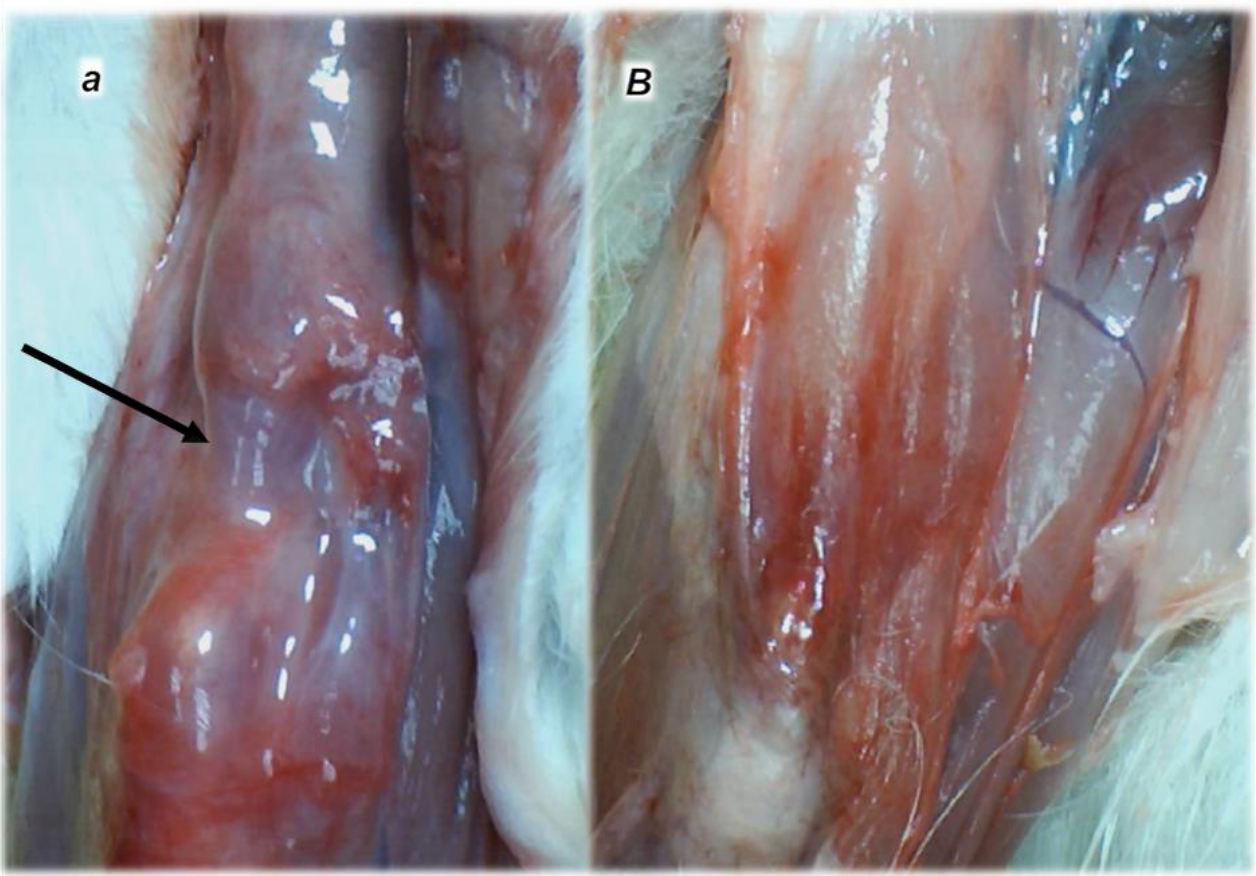
Figure 4. Characteristic presentation of the myotendinous junction healing at six months following dissection of quadriceps tendon from the quadriceps muscle [43] ( a , B ). Failed myotendinous junction occurred in the controls ( a ) (gap consequent to dissection of quadriceps tendon from quadriceps muscle (arrow)) and fully reestablished myotendinous junction in the rats treated with BPC 157 (capitals) (10 ng/kg/day orally, in drinking water) ( B ).